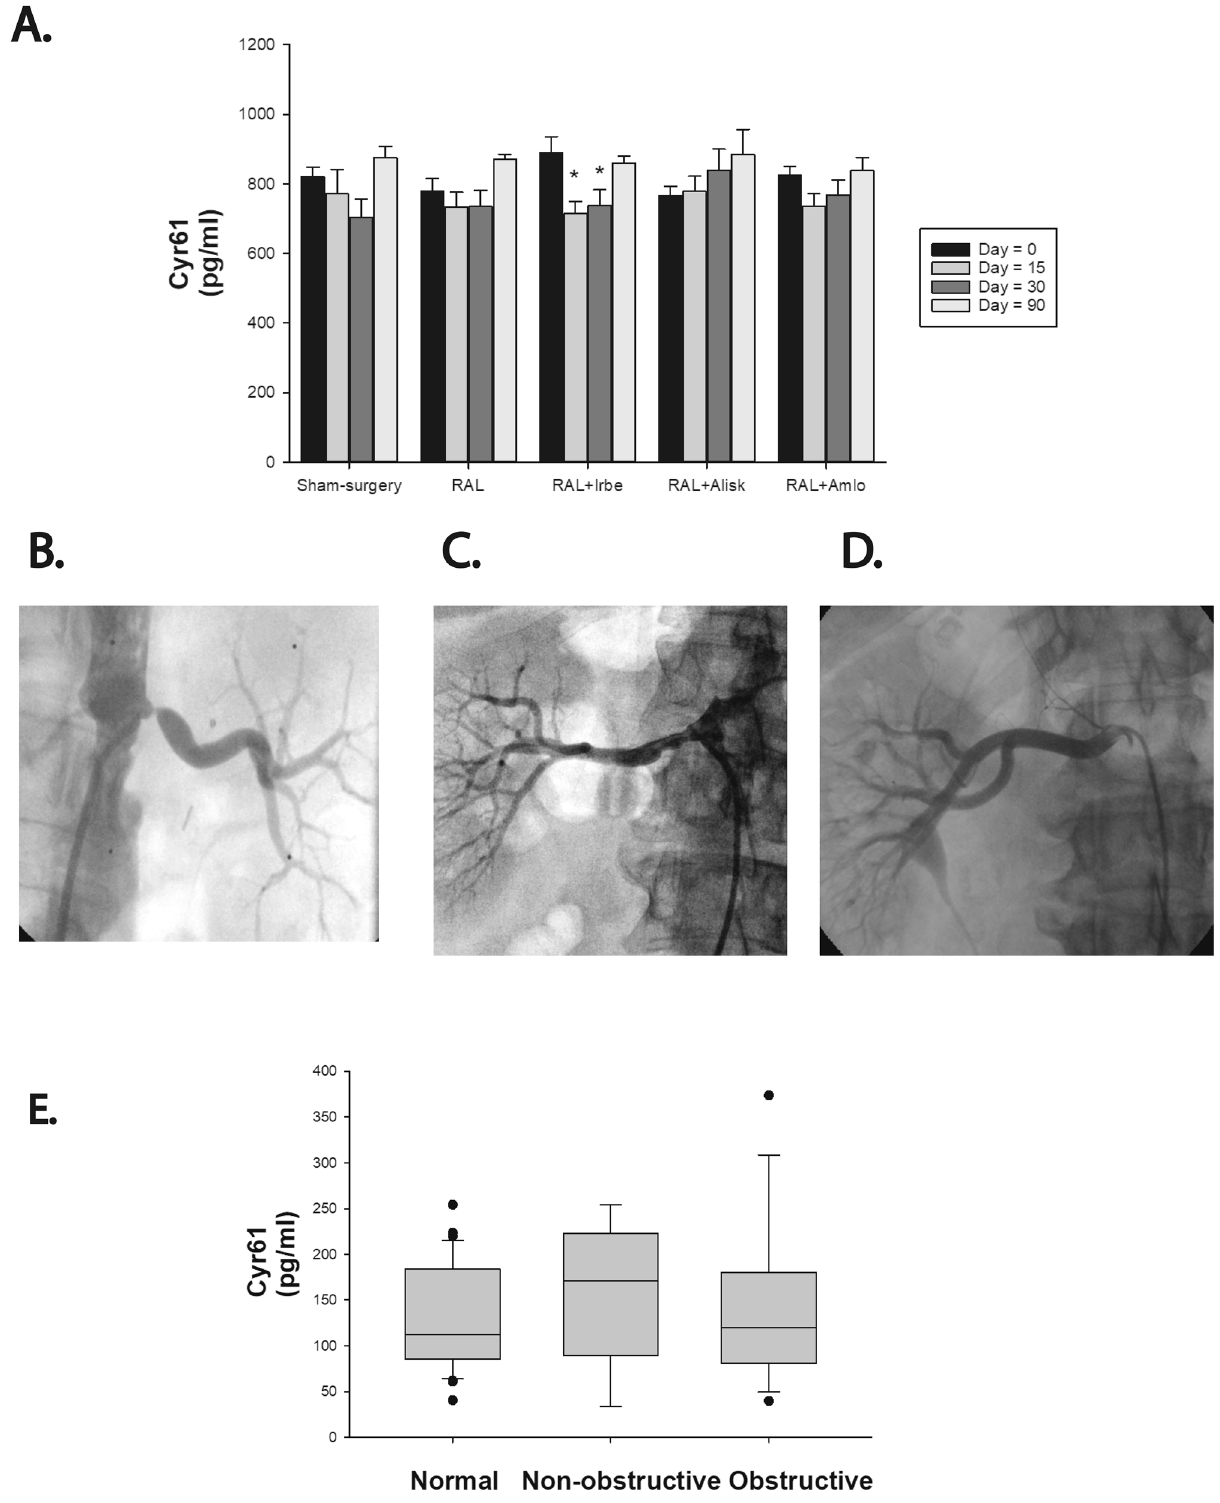
Figure 4. Serum levels of Cyr61 in mice and humans. Serum levels of Cyr61 in mice with unilateral renal artery ligation were determined from tail vein blood immediately prior to surgery and then at 15, 30 and 90 days after surgery ( A ). Representative images of a renal angiogram from a patient with obstructive RAS ( B ), non-obstructive RAS ( C ) or normal renal arteries ( D ). Serum levels of Cyr61 in each group as determined by a commercially available ELISA assay ( E